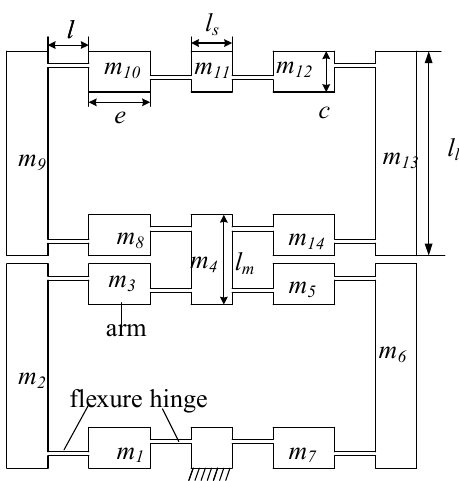
Figure 3. Structure of the double-row bow-type micro-displacement amplifier (DBMA).